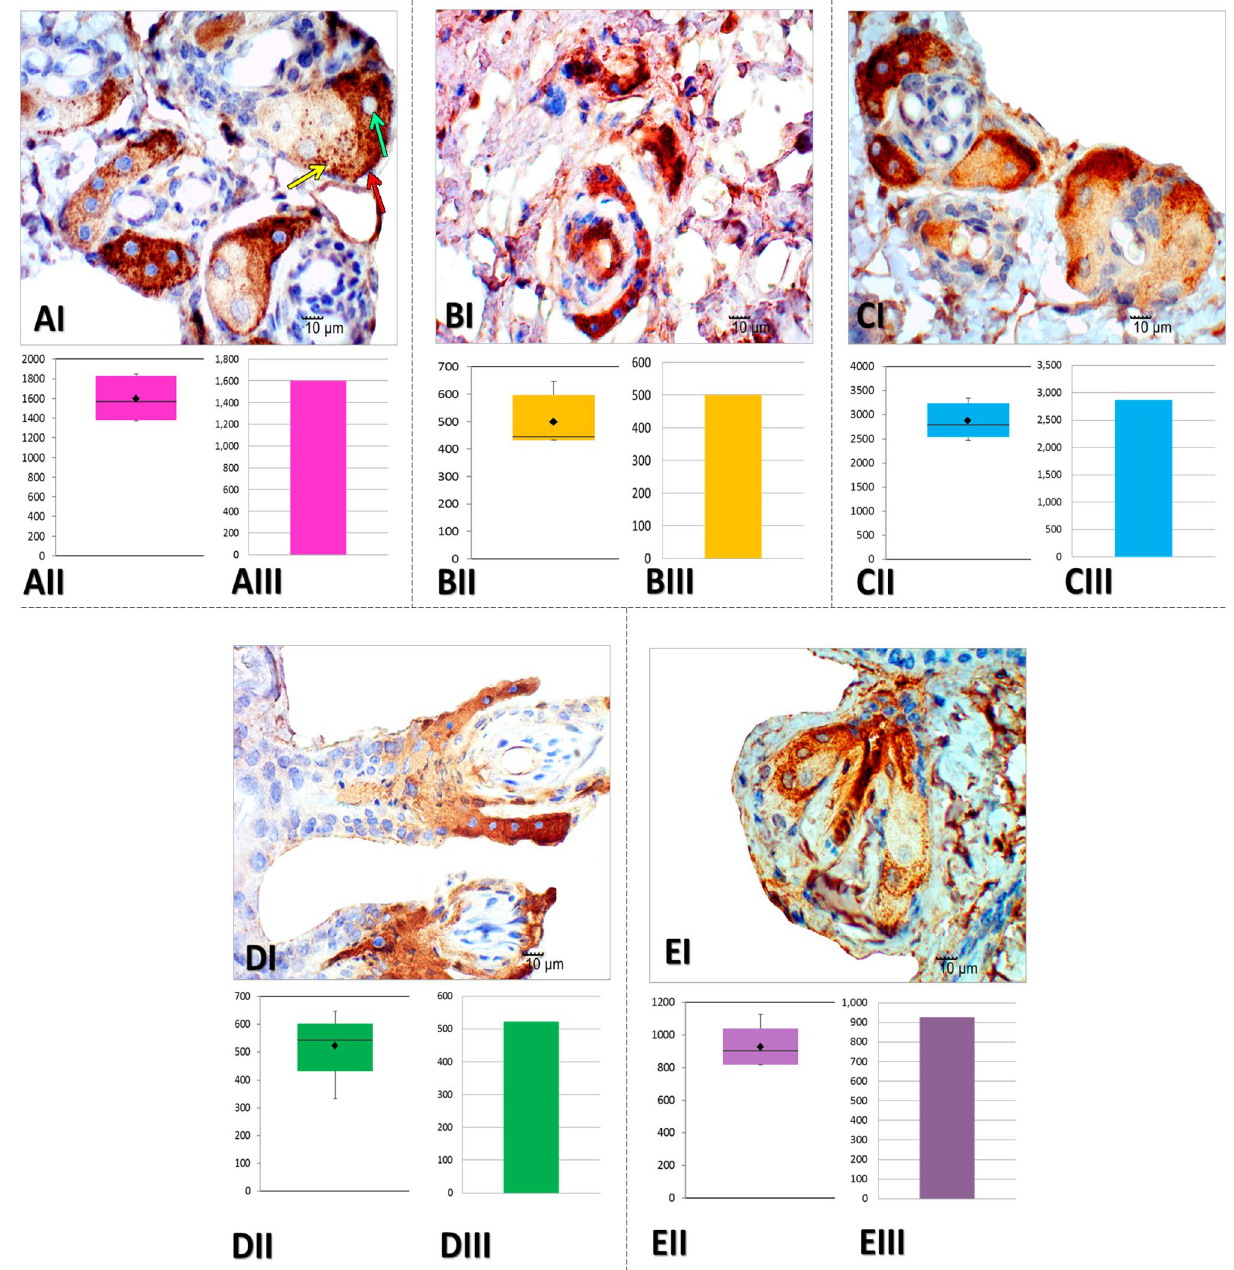
Figure 2. Photomicrographs (×600) of paraffinized tissue sections of mice analyzed by ADPH immunohistochemistry. ( AI ) Notice the fine staining of fat and intracytoplasmic lipid expression in sebaceous cells (yellow arrow). This technique allows us to identify cellular limits (red arrow) and the presence of nuclei (green arrow), as well as expressive differences in the sebaceous glands’ size. ( AI ) Control group. ( BI ) UD group. ( CI ) DS group. ( DI ) DNa group. ( EI ) DS-Na group. ( AII , BII , CII , DII , EII ): sebaceous gland area (µm 2 ) box plot evaluated in control group, UD group, DS group, DNa group and DS-Na group, respectively. ( AIII , BIII , CIII , DIII , EIII ) Average of the sebaceous gland area (µm 2 ) evaluated in the control group, UD group, DS group, DNa group and DS-Na group,